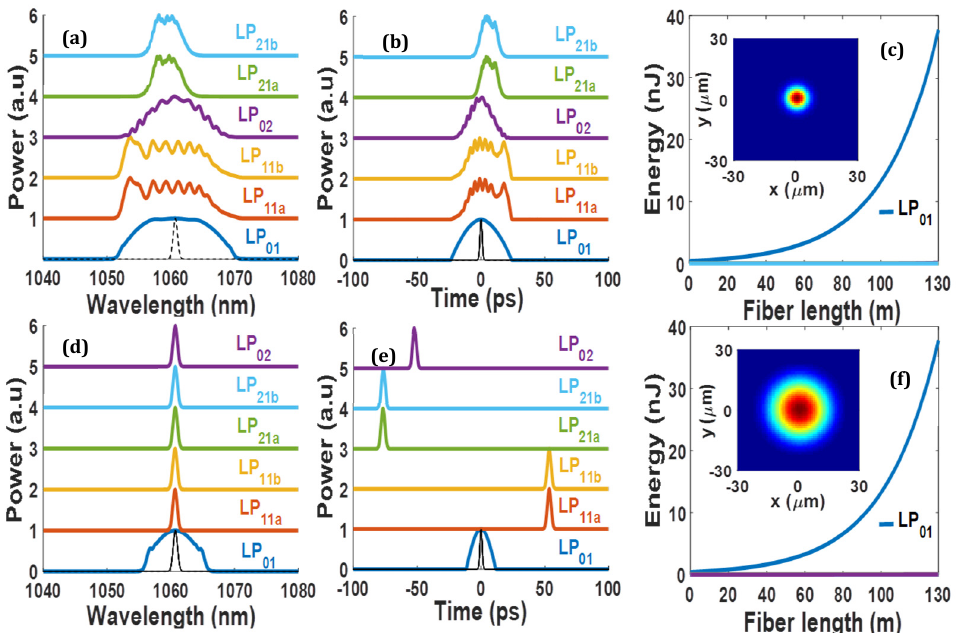
Figure 3. ( a – c ) Spectral, temporal forms and pulse energy evolutions for 130 m of pulse propagation for all the modes in the GRIN-F and ( d – f ) in the STEP-F, respectively, where the most initial energy is coupled in the LP 01 mode. Inset: output spatial beams.